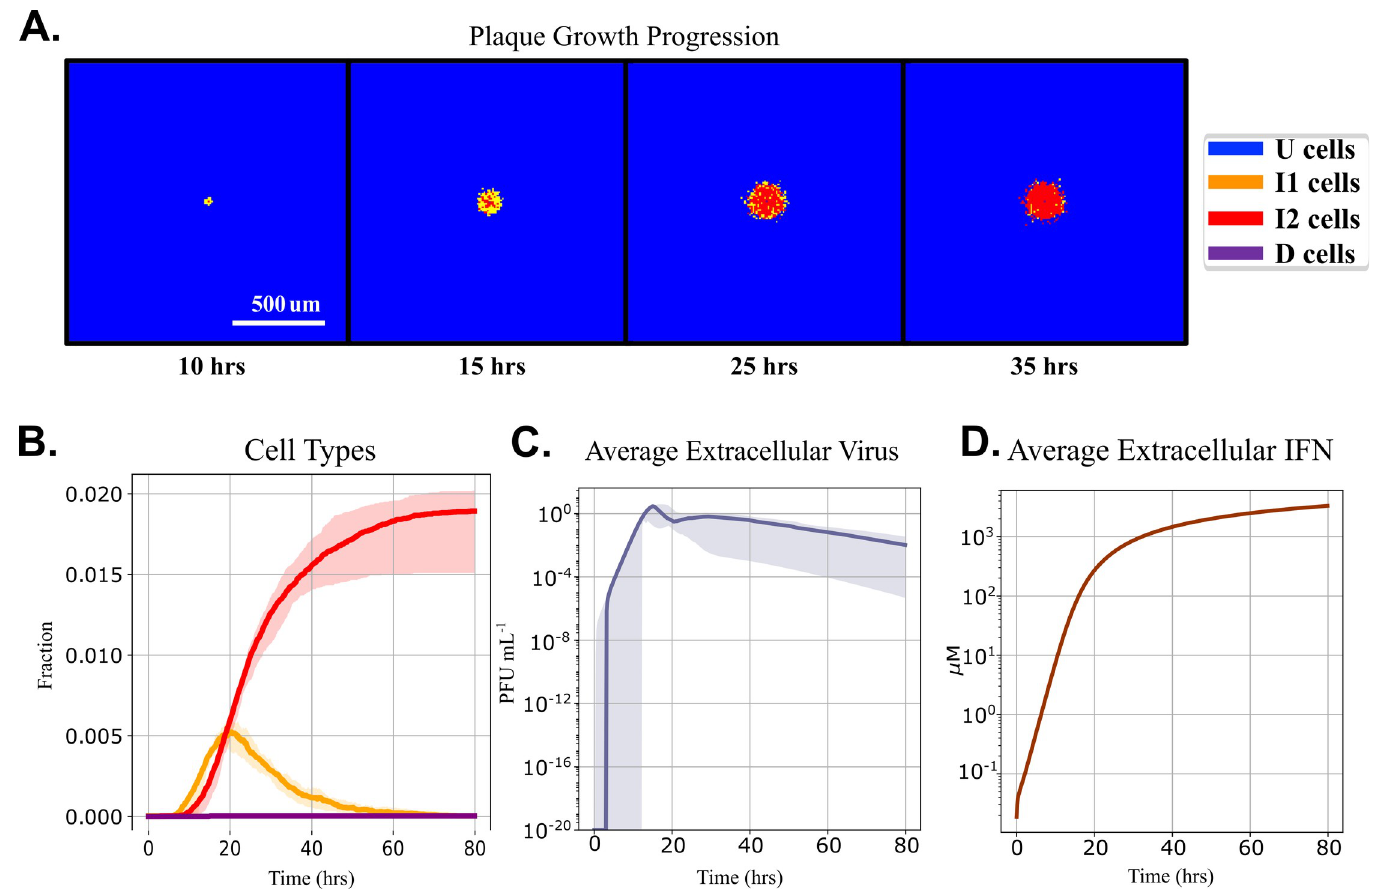
Fig 7. Prestimulating cells with type-I interferon led to plaque growth arrest in simulations. We simulate an experiment with 0.04 μ M IFN e prestimulation for 12 hours, which is removed immediately before infection. (A) Sequential snapshots (at 10, 15, 25 and 35 hours post-infection) of plaques for a representative simulation replica. (B) Cell type fractions vs time. (C) Average V e vs time and (D) the average IFN e vs time. The solid lines indicate medians and shaded areas represent the 5 th and 95 th percentiles over 20 replicas.